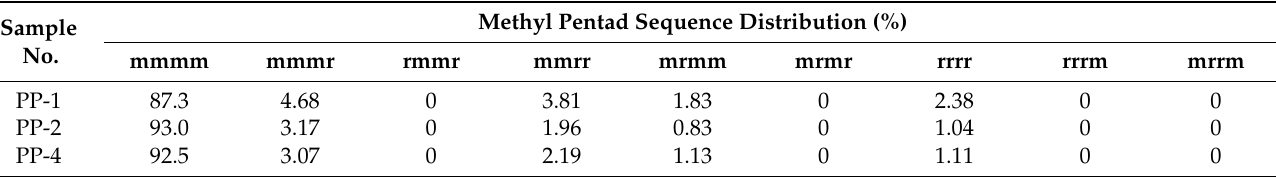
Figure 8. The 13 CNMR spectra of three PP samples from cat-1, cat-2 and cat-4. Table 6. Methyl pentad sequence distribution results of iPP from 13 C NMR analysis.